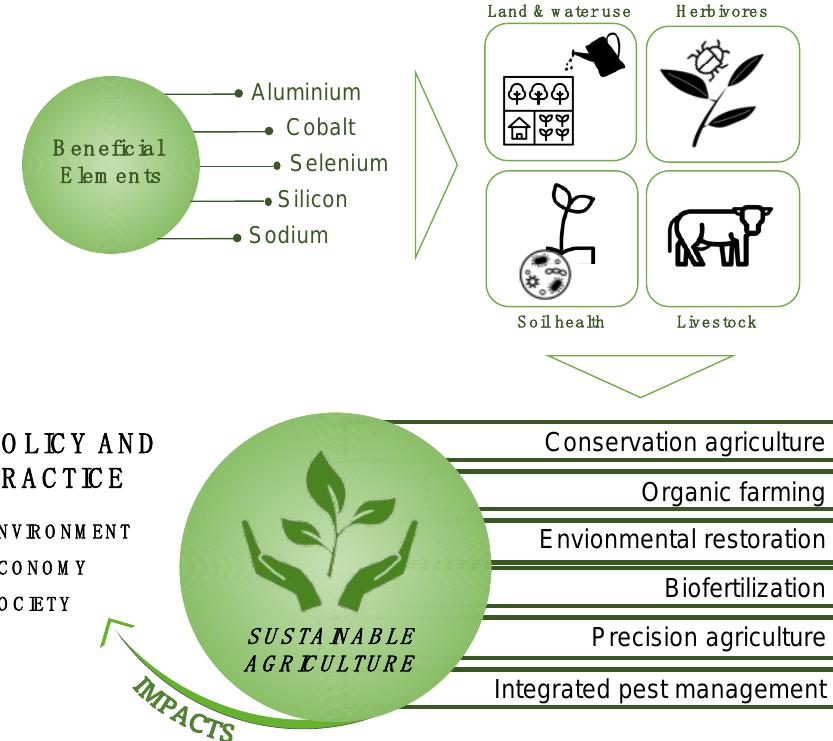
Figure 1. The role of beneficial elements in sustainable agriculture, plus the main contributions and impacts. As beneficial elements impact land and water use, herbivores’ life cycle, soil health, and livestock feed and management, they can contribute to different practices related to sustainable agriculture. Hence, their optimised use can contribute to the environment, economy, and society.